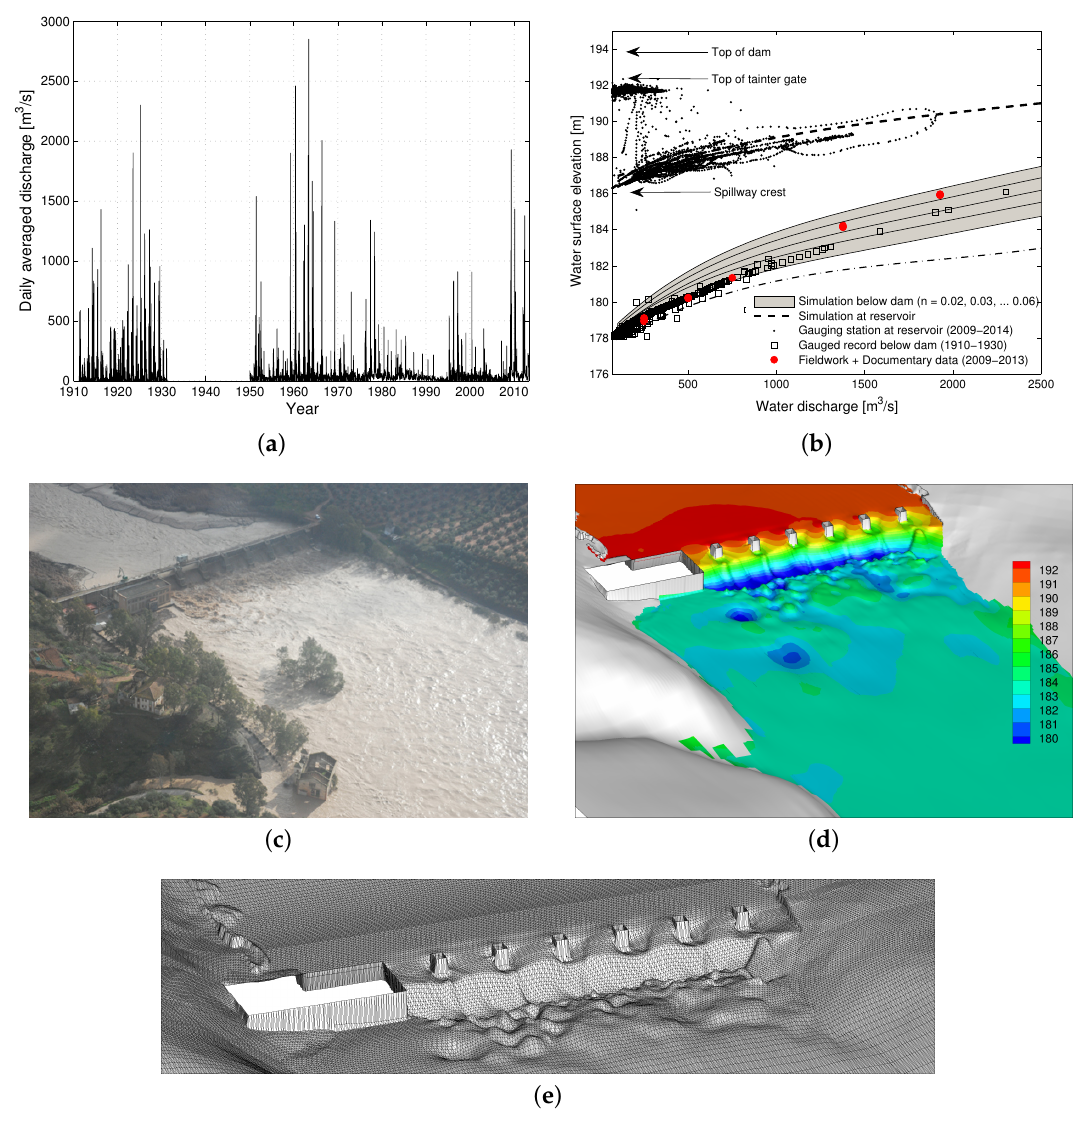
Figure 2. ( a ) Flood frequency distribution and relative magnitude of the Guadalquivir river instrumental floods at Marmolejo dam; ( b ) Rating curve upstream and downstream of the dam; ( c ) Flooded area below Marmolejo dam on 24 February 2010 for Q = 1847 m 3 · s − 1 . The distance between the old and new hydropower is nearly the same as the length of the dam, i.e., 195 m; ( d ) Detail of the water surface elevation; and ( e ) the computational mesh as for panel ( c ) with Q = 1900 m 3 · s − 1 and n = 0.06 s · m − 1/3 . The grid resolution is < 1 m at the spillways and progressively coarser ( < 10 m) over the valley. The simulated water surface is nearly flat (vanishing free surface slope) few meters downstream of the dam in agreement with observations in panel ( c ). Note the similarity between the modelled hydraulic structure and the real one as well as the modelled and observed inundated